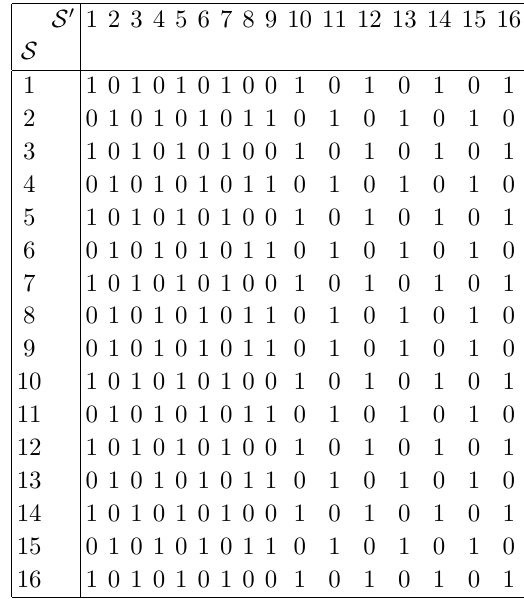
Table 17 . Gadget values for P